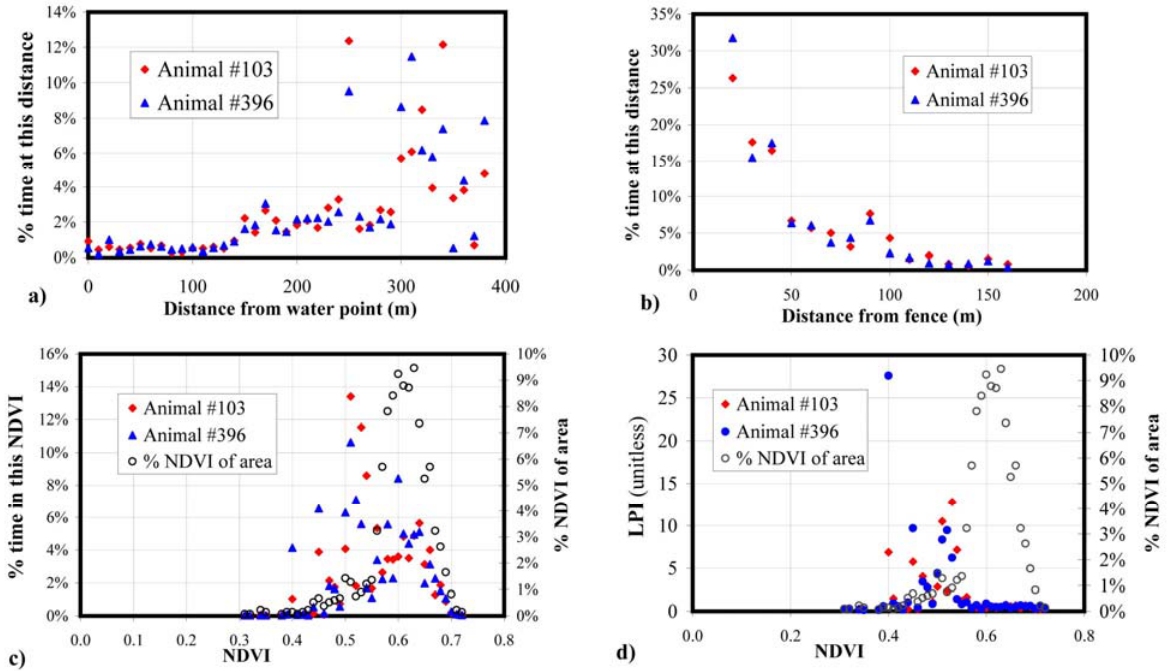
Figure 7. For animals number 103 and 396 during the three day trial, and for the area in front of the virtual fence, (a) the percentage time spent at each distance from the watering point. (b) The percentage time spent at each distance from the fence lines, both virtual and physical. (c) The percentage time spent within pixels of each NDVI value (d) The LPI for each NDVI